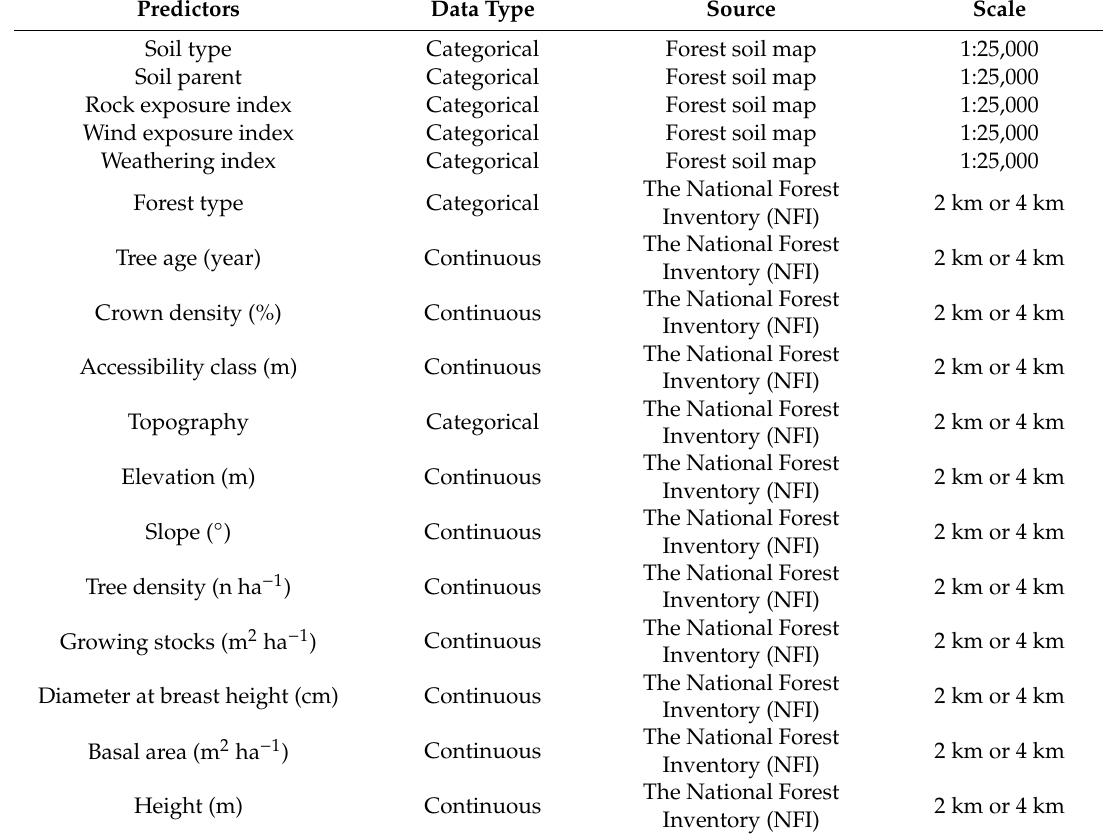
Table 2. List of predictors using data sources of soil and litter carbon stock in South